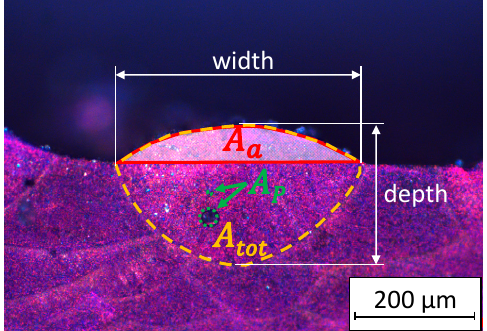
Figure 1. Cross-section of a processed sample, which was anodically etched according to Barker [34]. The total area of the melt bead A tot (orange dashed line) and the area A a of the added layer (red line and filling in white) were used to determine the process efficiency. The cross-sections of the pores A P that are contained within the analyzed bead are marked by green dashed lines.